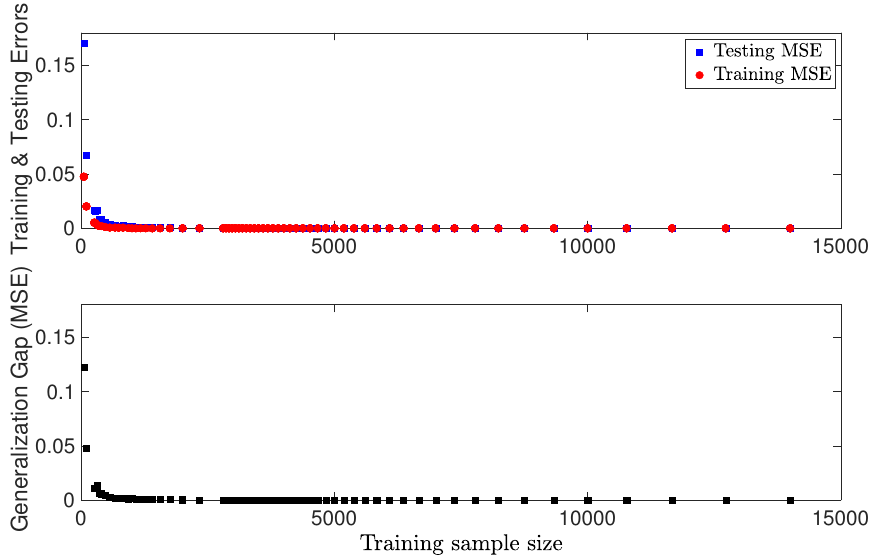
Figure 2. RNN generalization performance vs. training sample